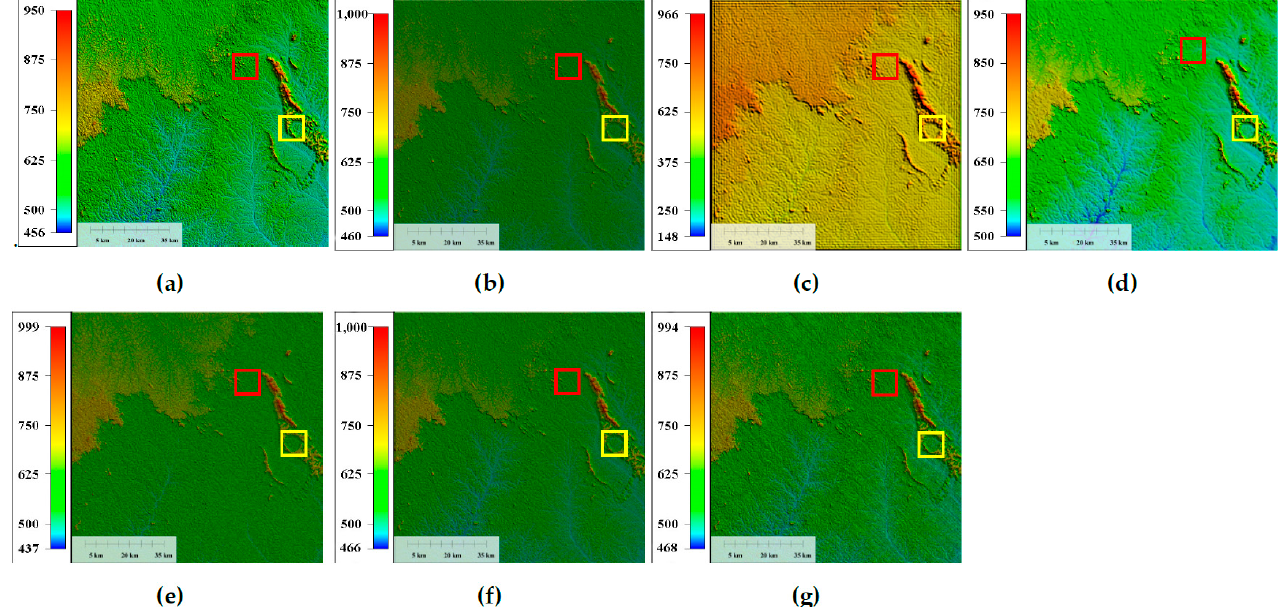
Remote Sens. 2021 , 13 , x FOR PEER REVIEW